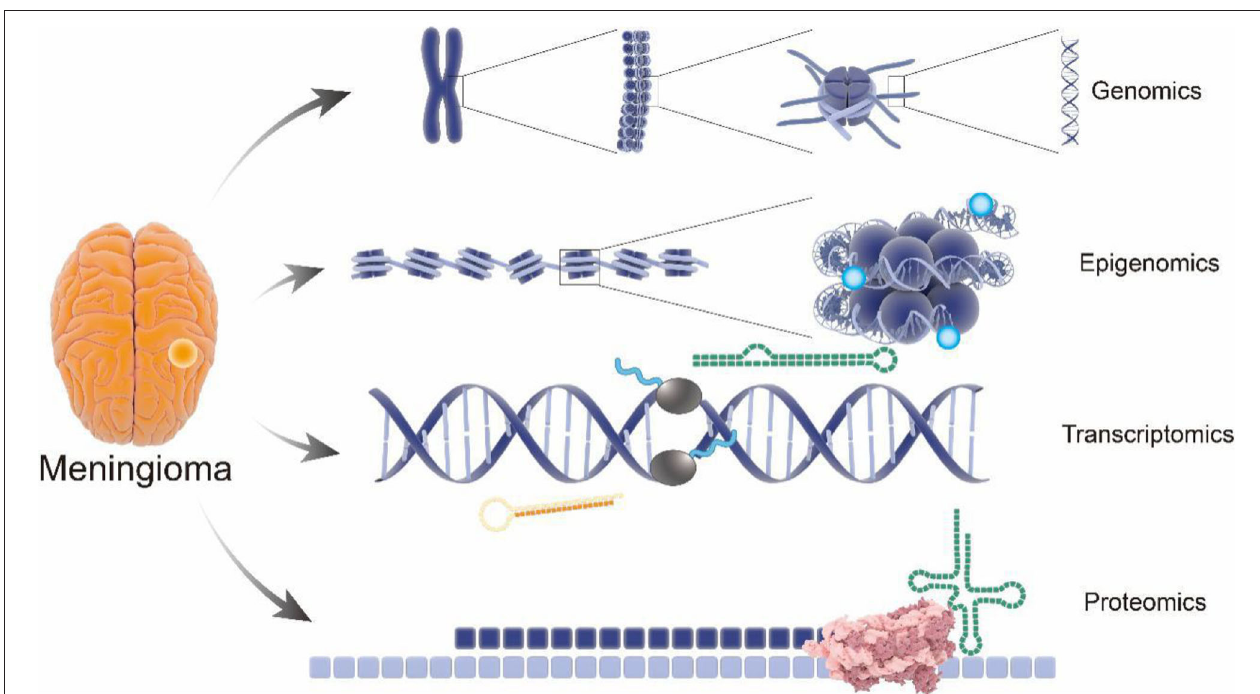
FIGURE 1 | Comprehensive analysis of pathology and molecular genetics of meningioma from multi-omics perspective. Structure of gene with the meningioma pathogenic variants have been revealed by genomics; performance of the epigenomics showing the influence of the genetic modification on meningioma; pathological gene expression in meningioma were analyzed by transcriptomics; applications of proteomics visually show the endocranial shape changes during meningioma. From genomics to proteomics, the pathological process and potential therapeutic targets involved in meningioma progression will be revealed as never before.